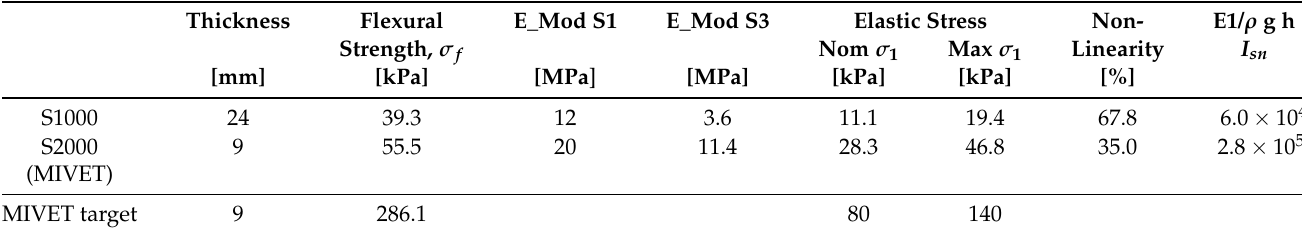
Table 1. Measured and simulated ice properties of S1000 and S2000, with S2000 MIVET. S2000 MIVET is set into relationship to S1000 and represents target properties based on Equation (11) and a = 2.7.